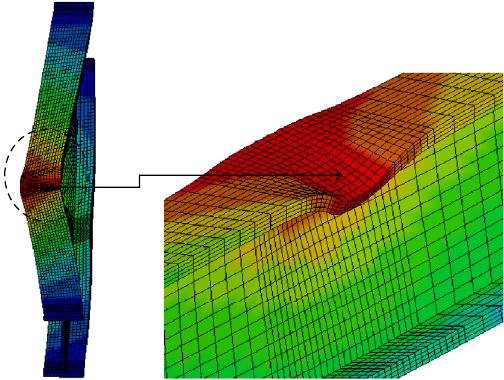
Figure 21: Plastic deformation of beam.